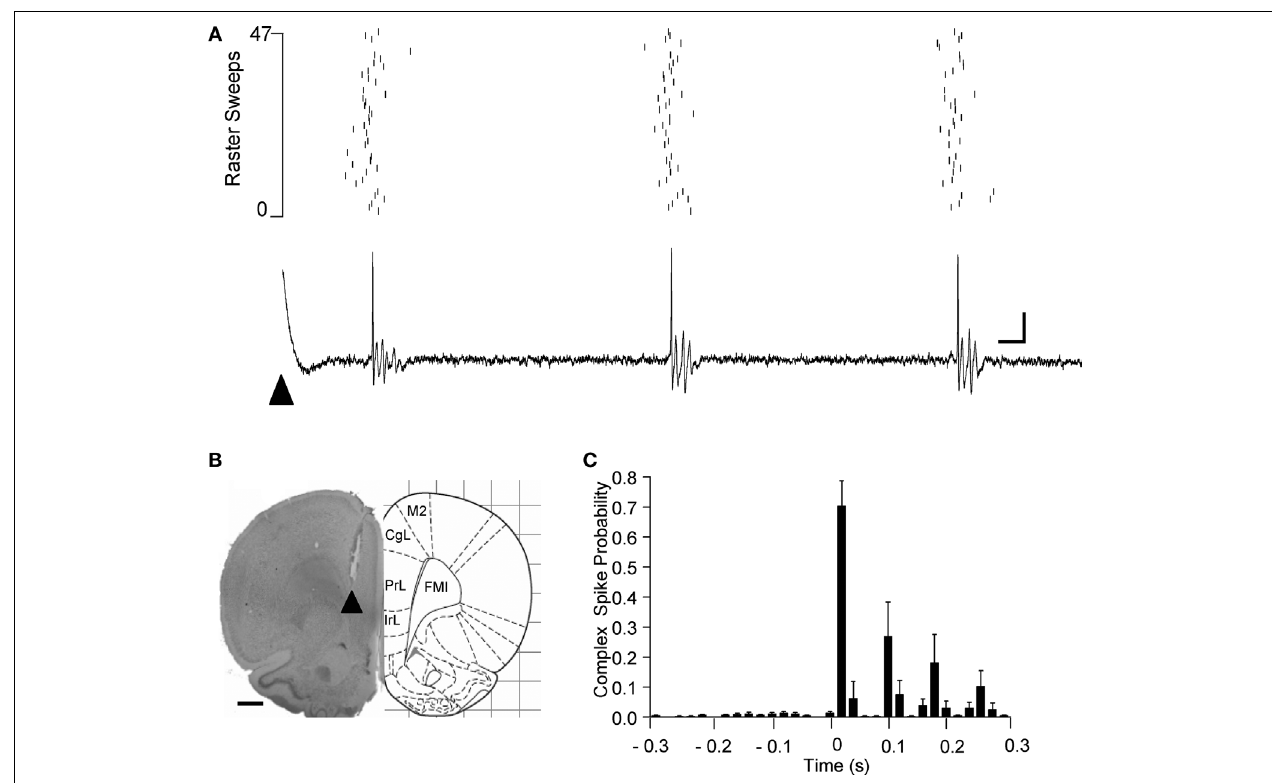
FIGURE 3 | Single unit Purkinje cell responses evoked by PrL stimulation. (A) Raster plot and example single sweep illustrating complex spike activity of a Purkinje cell located in a superfi cial cortical layer in contralateral vermal lobule VII evoked by PrL stimulation (arrowhead). Raster = 47 consecutive trials. (B) Histological verifi cation of the site of PrL stimulation (arrowhead) for the experiment shown in A (adapted from Paxinos and Watson, 2005).